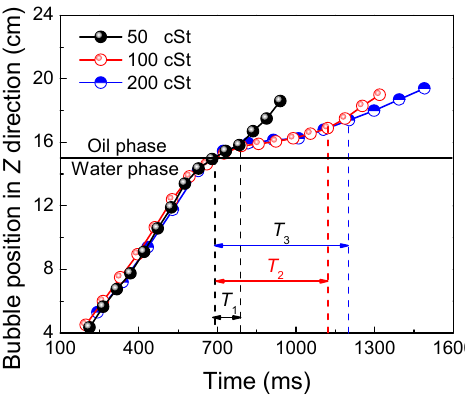
ff erent times ( Q = 50 mL /